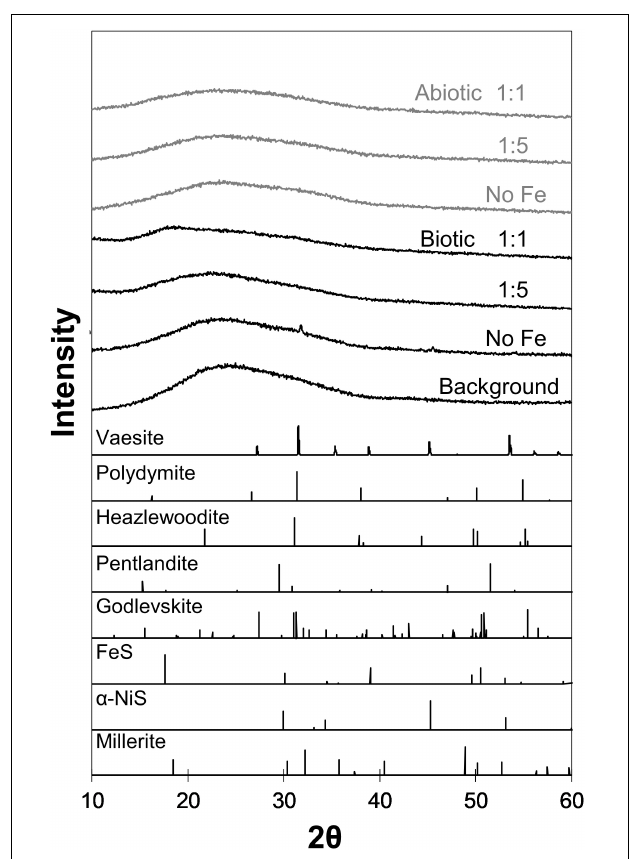
FIGURE 1 | XRD patterns of biogenic (black) and abiogenic (gray) precipitates shown at the upper portion of the figure, with corresponding standard patterns of select Ni-Fe-sulfides (from American Mineralogist database accessed on February 2019; Downs and Hall-Wallace, 2003) shown at the bottom portion. Background signal contributed by the glass slide is also included in the figure. Most samples are indistinguishable from the background except “Biotic No Fe” and “Biotic 1:1 Ni:Fe”